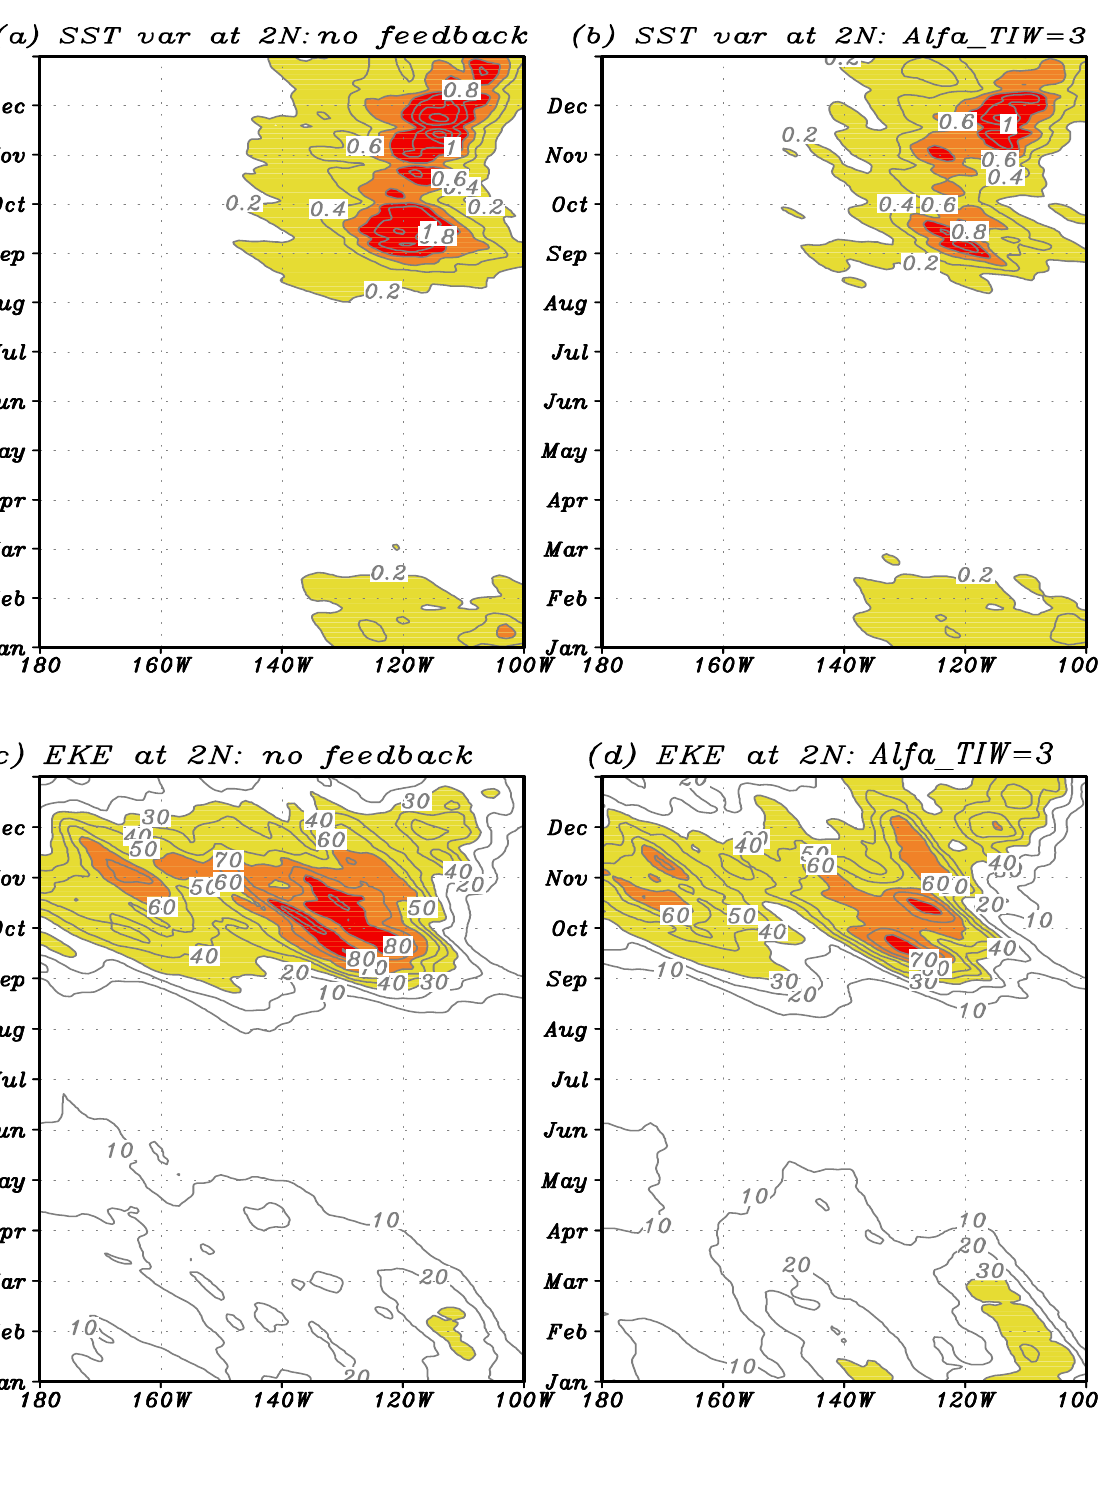
Figure 6. Seasonal variations along 2  N for the sdv of SST eddy kinetic energy (EKE) (low panels) calculated from the OGCM simulations (left panels) without and (right panels) with the TIW wind feedback, respectively. The calculations are made from daily SST and surface mixed-layer current data in year 13. The contour interval is 0.2 °C in (a,b), and is 10 kg·m −1 ·s −2 in